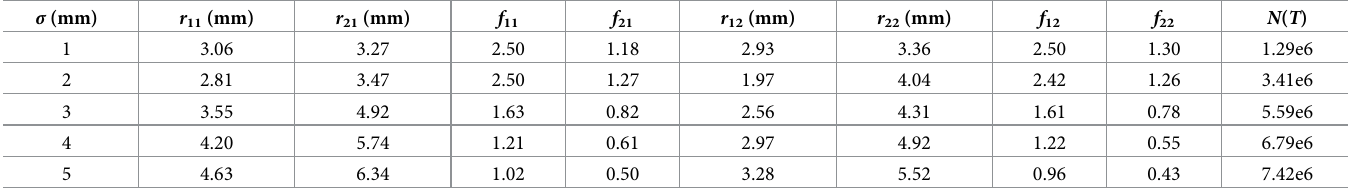
Table 5. Two two-step fractions, mutually constrained. σ